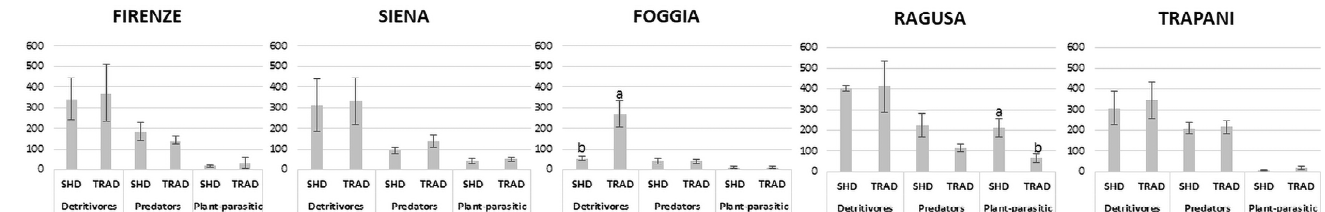
Figure 2. Diversity-weighted abundance ( θ ) for functional classes of soil assemblages in five Italian sites. SHD, super-high-density olive orchards; TRAD, traditional olive orchards. Different letters indicate significant differences at p < 0.05. Standard errors are reported.